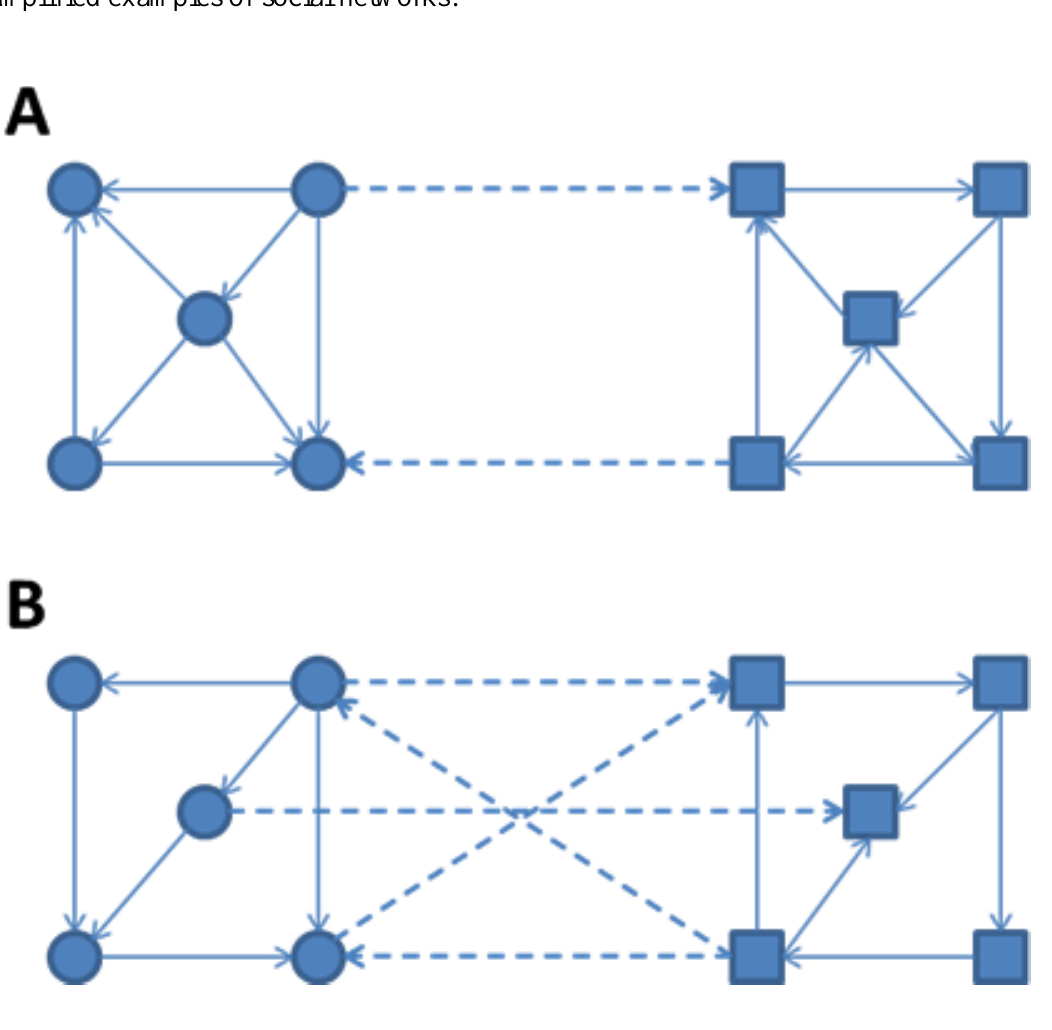
Fig. 3. Simplified examples of social